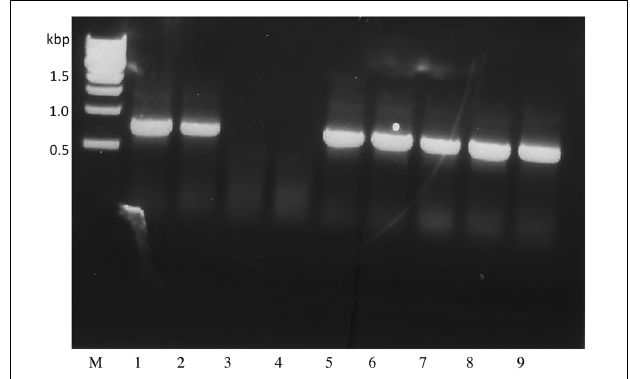
FIGURE 1 | Triple Null soybean is transformable via biolistic transformation of somatic embryos. Genomic PCR was performed on T 1 segregating Triple Null plants transformed with the hygromycin resistance marker gene expression cassette. Presence of the PCR amplicon ∼ 700 bp in all samples except 3 and 4 indicate the presence of the hygromycin gene in those plants DNA, indicating a stable transformation event that is segregating in an expected Mendelian